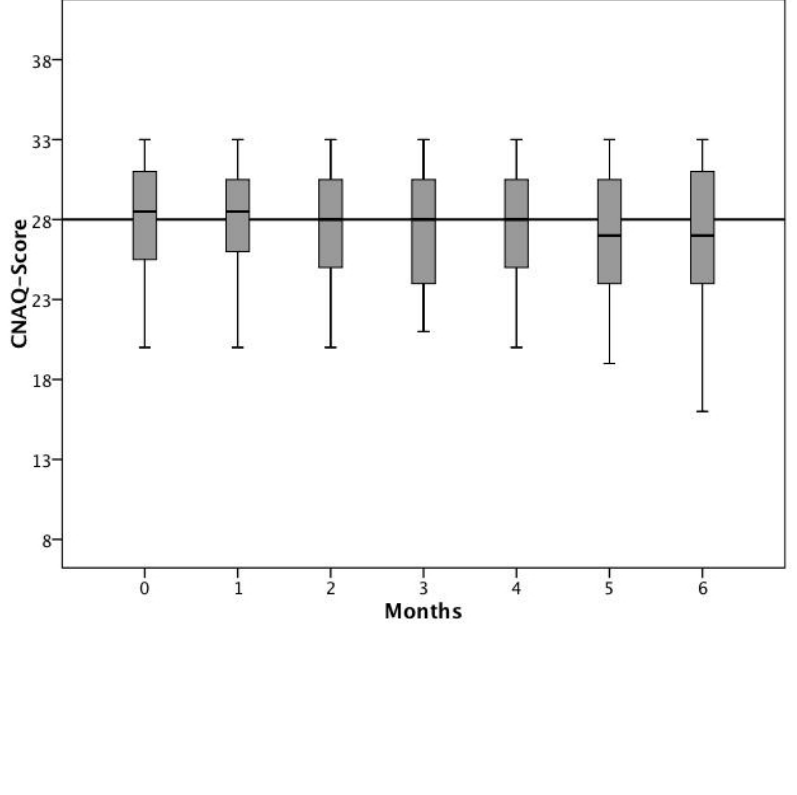
Figure 3. Box plots of CNAQ scores in the course of 6 months; patients receiving PEG (n=8) were excluded in the